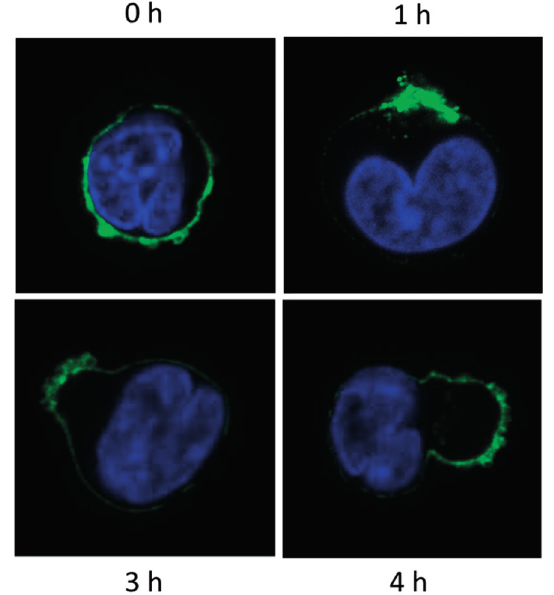
Figure 6. Confocal microscopy analysis of CD38/DARA (Daratumumab) interaction at 37 °C on the human BF01 myeloma